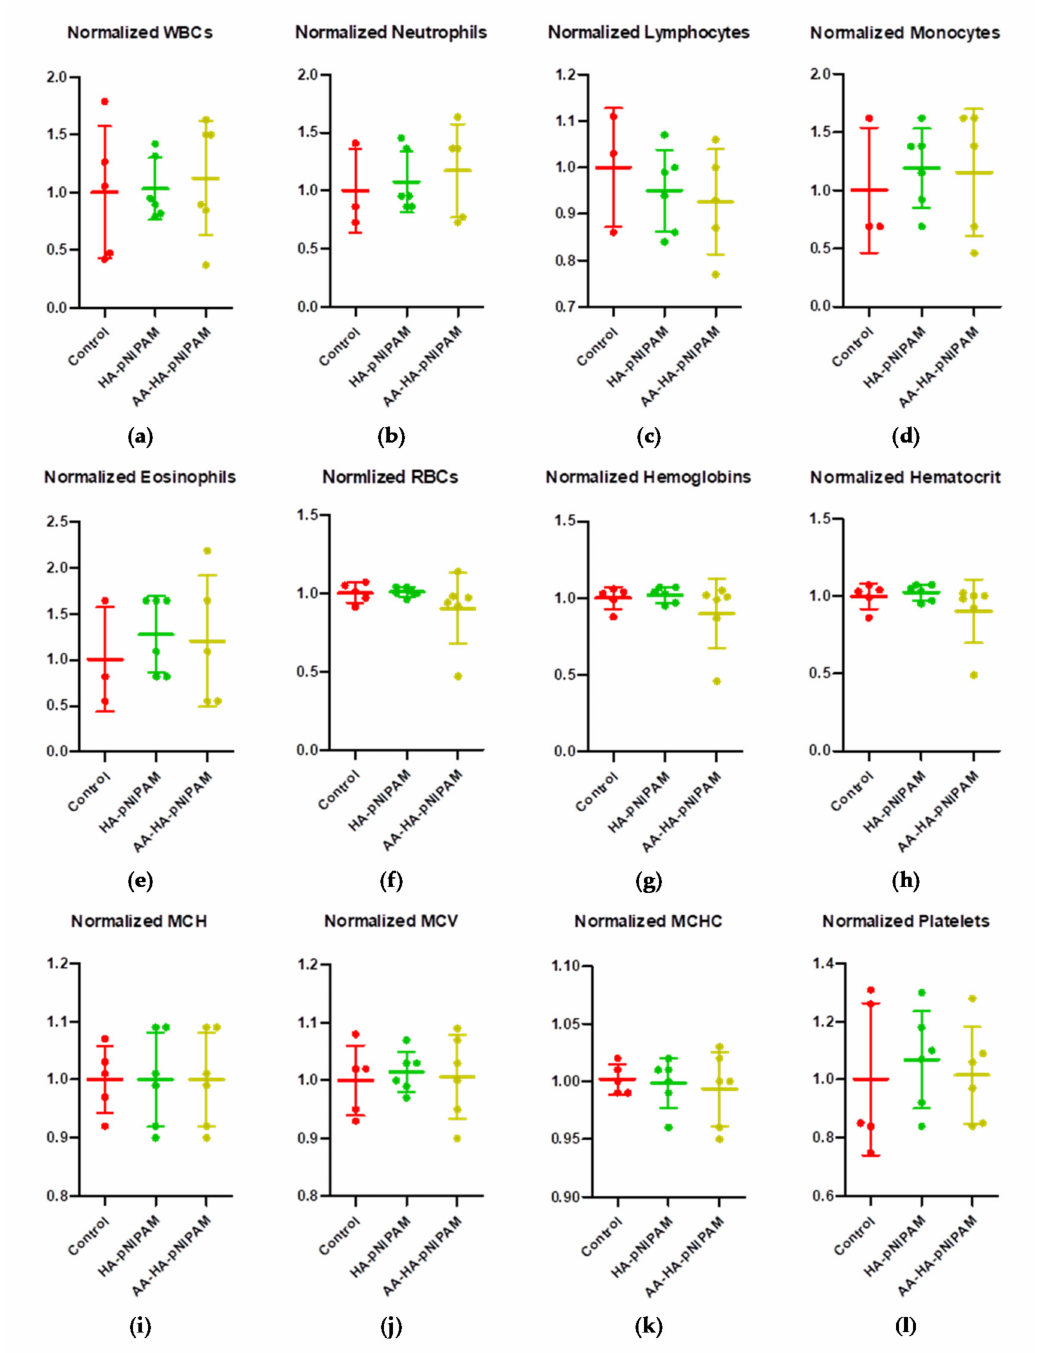
Figure 7. Hematological changes in rats treated with control, HA-pNIPAM and AA-HA-pNIPAM. The hematological parameters analyzed were ( a ) white blood cells (WBCs), ( b ) neutrophils, ( c ) lymphocytes, ( d ) monocytes, ( e ) eosinophils, ( f ) red blood cells (RBCs), ( g ) hemoglobin, ( h ) hematocrit, ( i ) mean cell hemoglobin (MCH), ( j ) mean corpuscular volume (MCV), ( k ) mean corpuscular hemoglobin concentration (MCHC) and ( l )